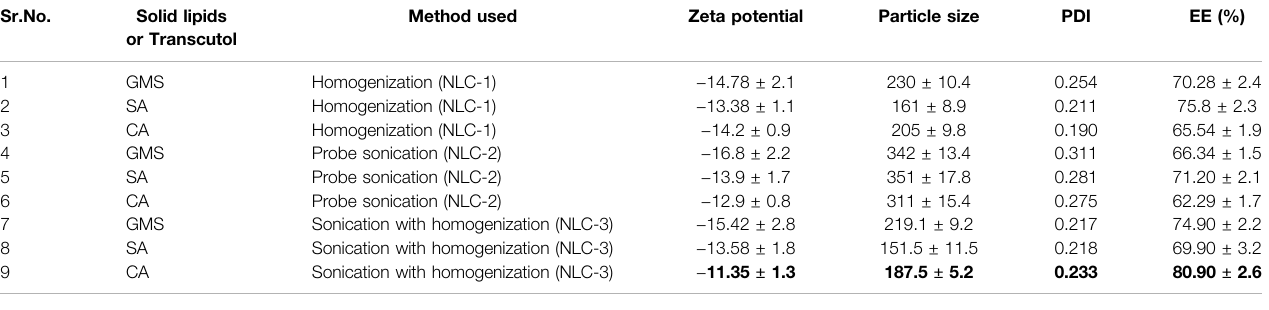
TABLE 1 | Characterization of NLC formulations with respect to size, zeta potential, and EE. Sr.No.